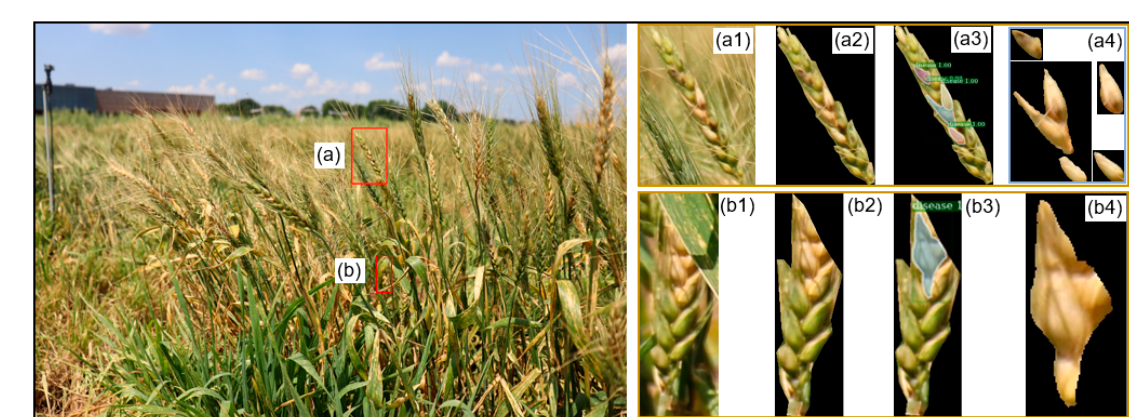
Figure 10. Examples of misjudgment of the diseased areas on ( a , b ) two wheat spikes; ( a1 , b1 ) zoom-in views of the spike; ( a2 , b2 ) Mask-RCNN for wheat spike detection; ( a3 , b3 ) Mask-RCNN for disease area identification; ( a4 , b4 ) the segmentation result of diseased spikelets.